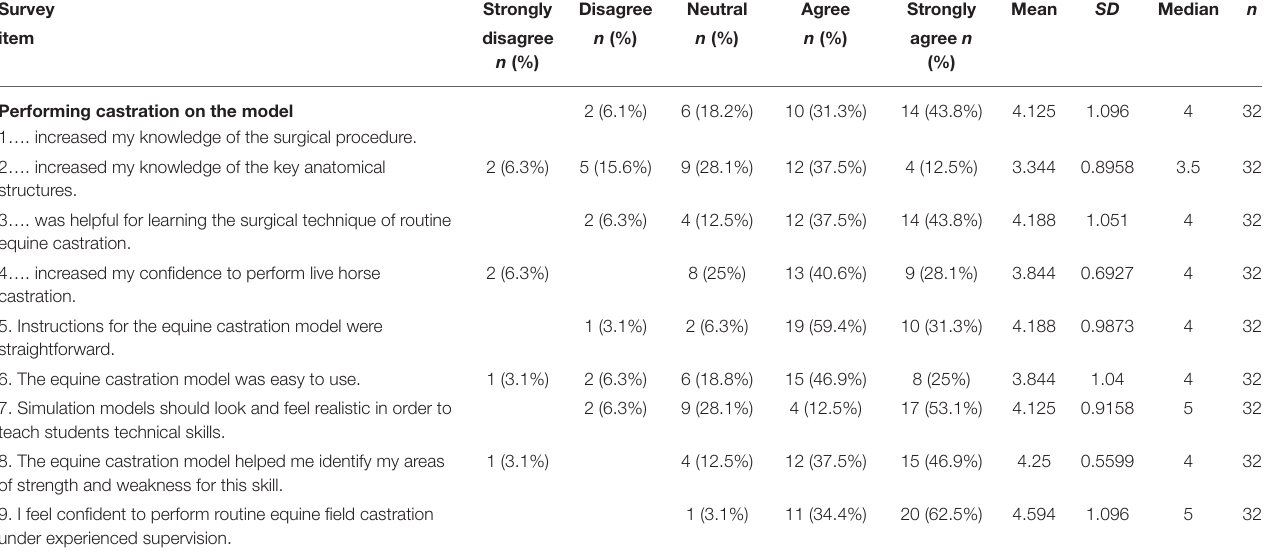
n (%) n (%) n (%) agree n n (%) (%)